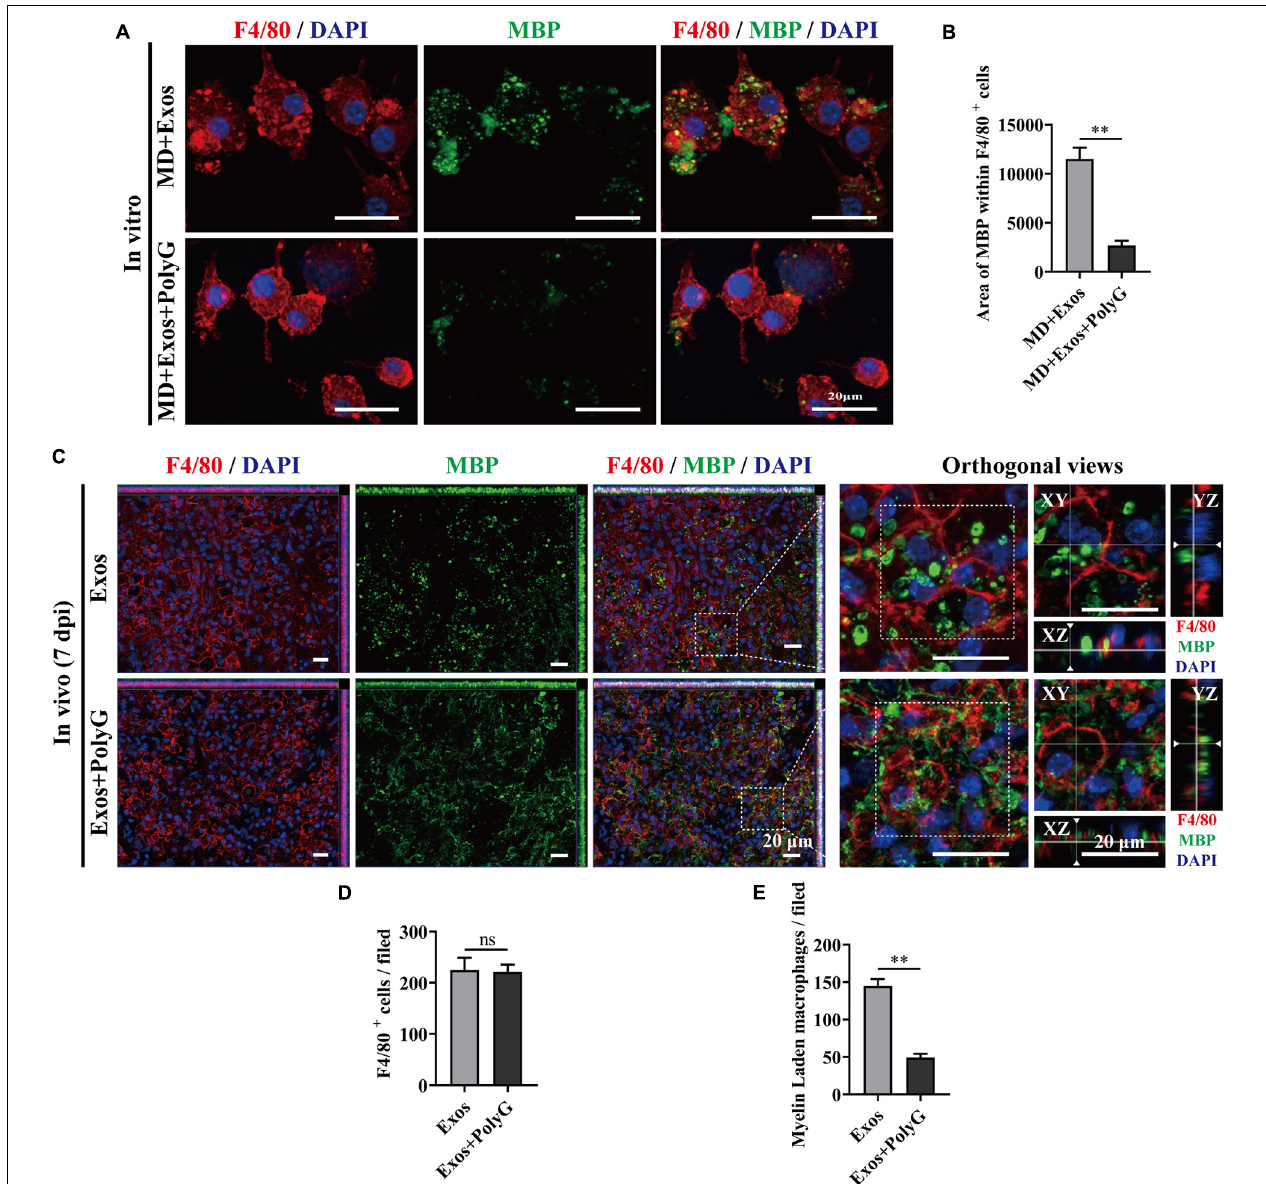
FIGURE 8 | Blocking macrophage receptor with collagenous structure (MARCO) impaired the ability of bone marrow mesenchymal stem cell-derived exosomes (BMSC-Exos) to promote macrophage phagocytosis of myelin debris both in vitro and in vivo . (A) Representative immunofluorescence images of myelin debris [myelin basic protein (MBP), green] uptake by macrophages (F4/80, red) in the MD + Exos and MD + Exos + PolyG groups. Nuclei were counterstained with DAPI (blue). Scale bar = 20 µ m. (B) Immunofluorescence semiquantification of the area of MBP within the F4/80+ macrophages ( n = 3 per group, values are the mean ± SD, ∗∗ p < 0.01, two-tailed Student’s t -tests). (C) Representative immunofluorescence images of myelin debris (MBP, green) uptake by macrophages (F4/80, red) in the lesion sites of the spinal cord in both the BMSC-Exos and Exos + PolyG groups at 7 days post-spinal cord injury (post-SCI). Nuclei were counterstained with DAPI (blue). Scale bar = 20 µ m. ( D,E ) Quantification of macrophages (F4/80, red) and myelin-laden macrophages (F4/80 red and MBP green) per field in the lesion site at 7 days post-SCI ( n = 5 per group, values are the mean ± SD, ∗∗ p < 0.01, two-tailed Student’s t -tests). ns, not significant; MD, myelin debris; PolyG, MARCO antagonist; 7 dpi, 7 days post-SCI.